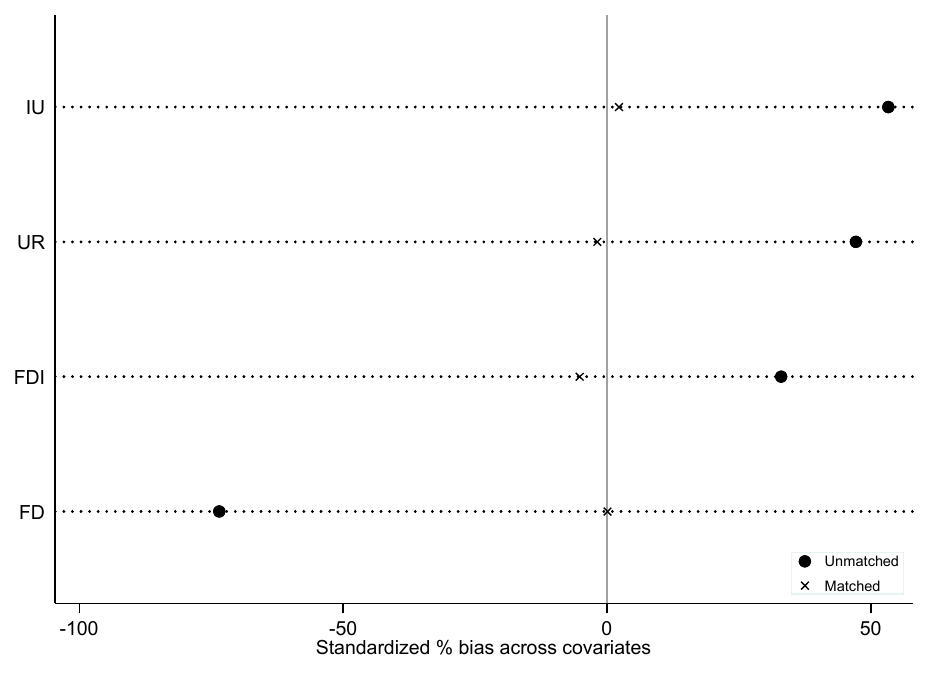
Figure 4. Covariate standardization bias test. Table 4. Parameter estimation results of the PSM-DID